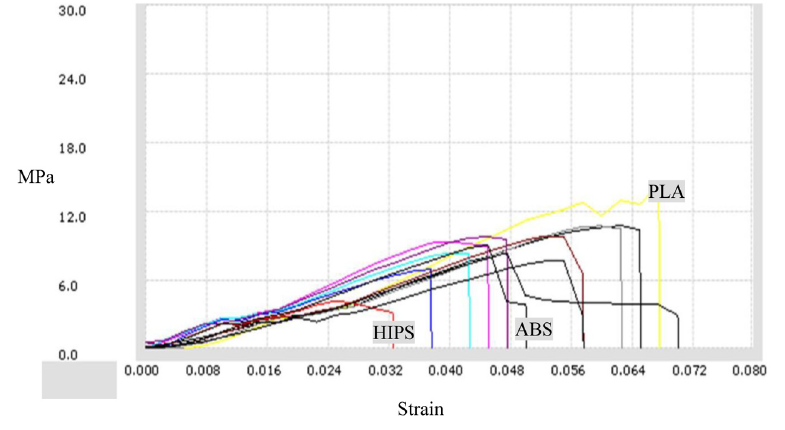
Figure 13. Stress Vs. strain curves for multilateral